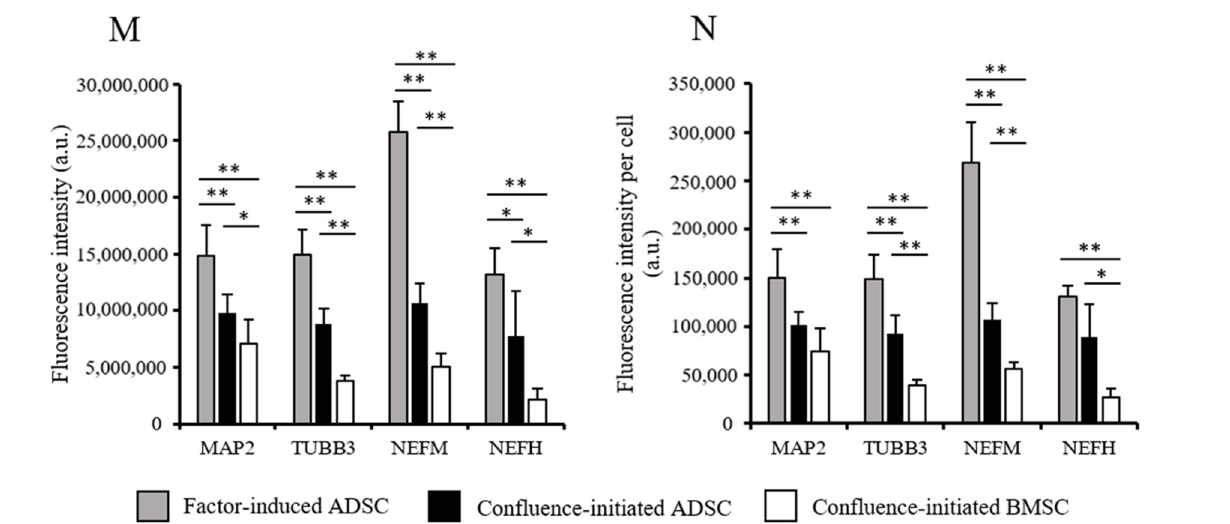
Figure 3. Comparison of neuron-related protein expressions of the ADSCs and BMSCs during confluence-initiated neuro- genic differentiation. ( A , E , I ) Class III β -tubulin (TUBB3), ( B , F , J ) microtubule-associated protein 2 (MAP2), ( C , G , K ) neu- rofilament medium polypeptide (NEFM), and ( D , H , L ) neurofilament light polypeptide (NEFL) of the factor-induced ADSCs, confluence-initiated ADSCs, and confluence-initiated BMSC differentiated neuron-like cells on day 7 detected by immunofluorescence staining are shown in green fluorescence. DNA stained by DAPI is shown in blue fluorescence (magnification × 100; the scale bar = 100 µ m). ( M ) The mean of the total immunofluorescence intensity from a fixed number of cells in six fields of one slide was quantified by the Image-Pro Plus v4.5.0.29. ( N ) The mean of the value that was normalized to the cell numbers in the field was calculated. All the values are expressed as mean ± S.D. with three experimental replicates. Statistical significance to compare the multiple groups was determined using one-way ANOVA analysis. “*” represents p < 0.05. “**” represents p < 0.01.